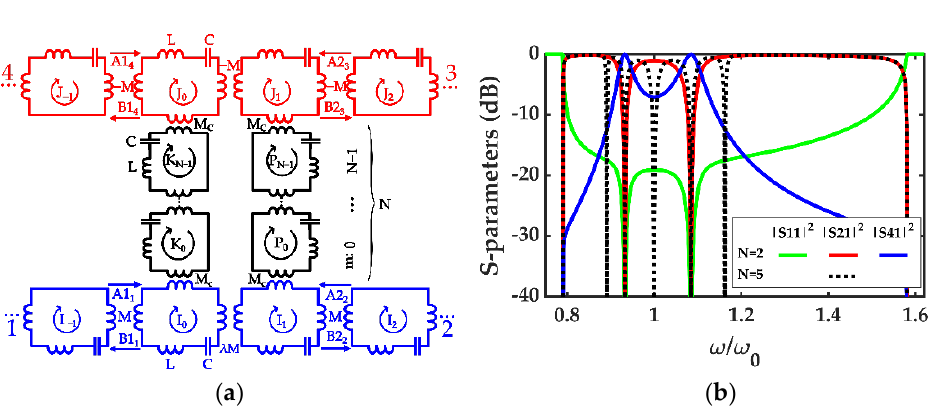
Figure 5. ( a ) Multiple bandstop MI directional filter; ( b ) frequency dependence of S-parameters for multiple passband filter with lossless MI terminations (1) for κ = 0.6 , κ c = 0.3 , 𝑁 = 2 , and 𝑁 = 5 .